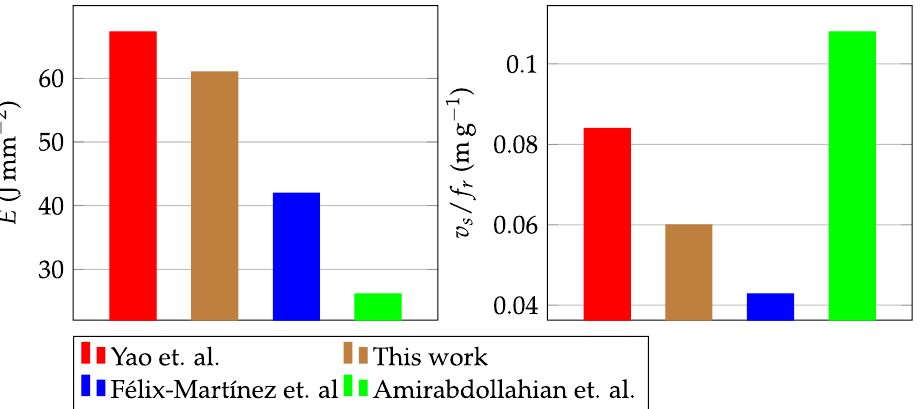
Figure 13. Comparison between the specific energy E and ratio between scanning speed and feeding rate v s / f r between the present work and other research: Yao et al. [29], Félix-Marínez et al. [28] and Amirabdollahian et al. [39]. The parameters shown by [28] were optimised for dilution work by Yao et al. [29] where the parameters resulted in a specimen with the largest tensile